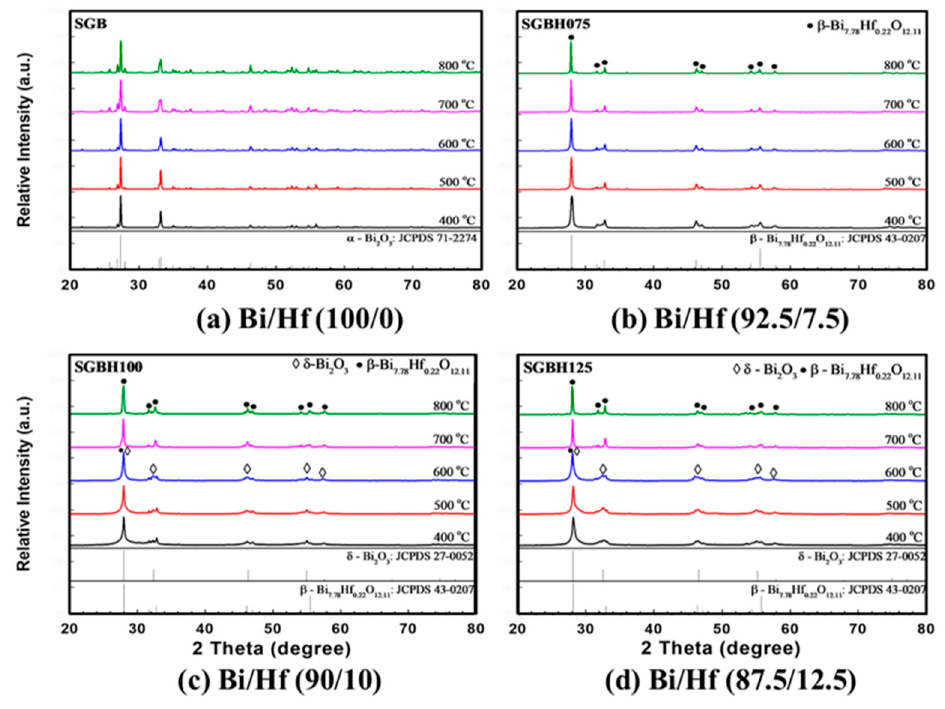
Figure 3. The X-ray diffraction (XRD) for various compositions of ( a ) Bi/Hf (100/0) ( b ) Bi/Hf (92.5/7.5) ( c ) Bi/Hf (90/10) ( d ) Bi/Hf (87.5/12.5) after calcination from 400 °C to 800 °C for 1 h.